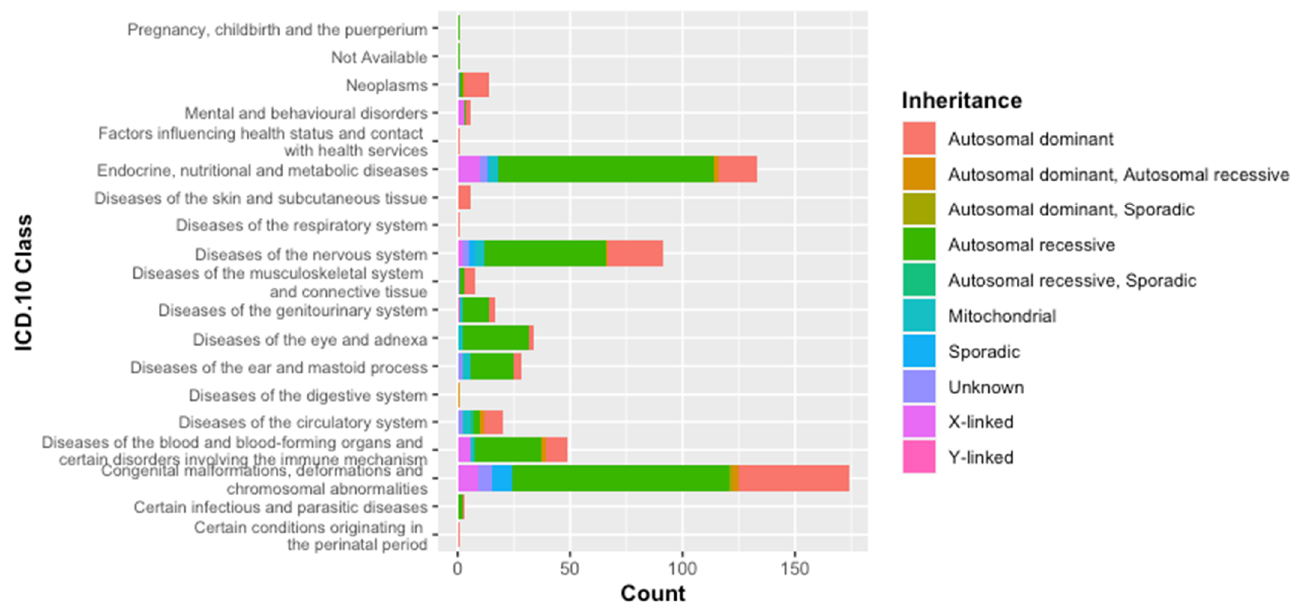
Figure 2 . WHO ICD-10 classification of genetic diseases . Figure 2. WHO ICD-10 classification of genetic